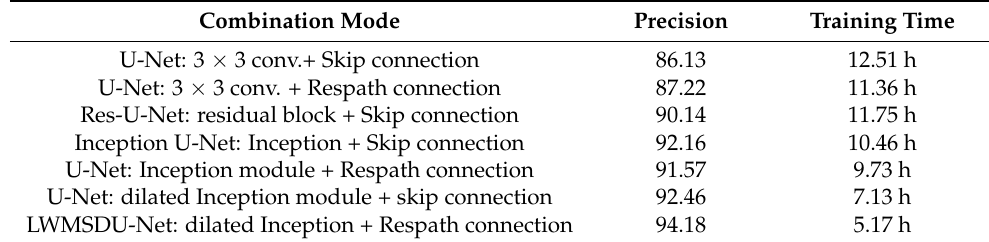
Table 3. Segmentation results by different combinations of convolution and